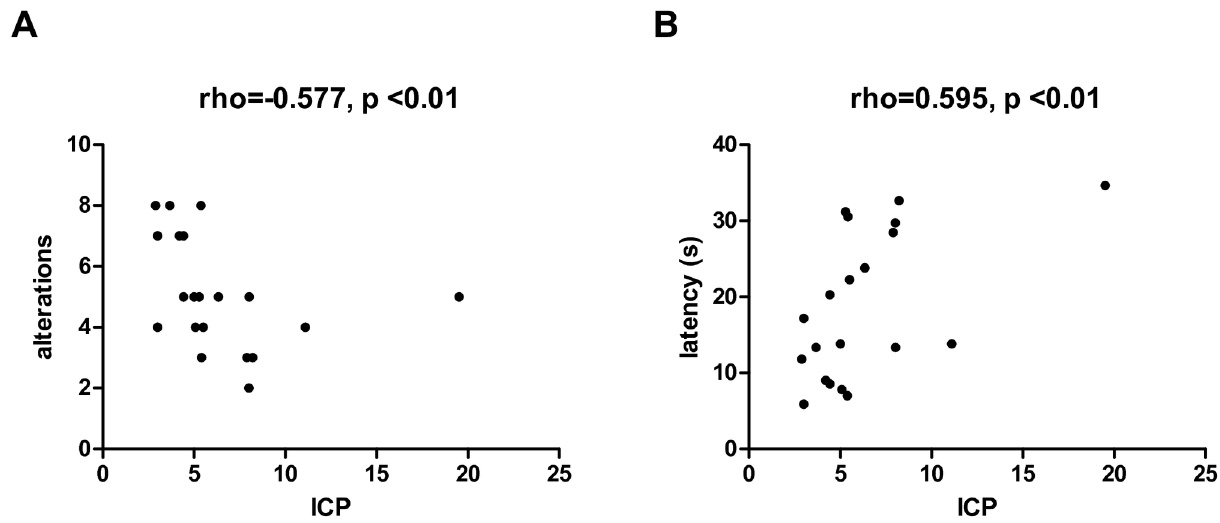
Figure 3. Correlation between behavior and intracranial pressure. Correlation analyses between the results of T-maze test at day 21 after surgery and intracranial pressure (ICP) in SHAM and SAH animals. Number of alterations (A) and mean latency to decision in seconds (B). Spearman’s rho and p-values are given.